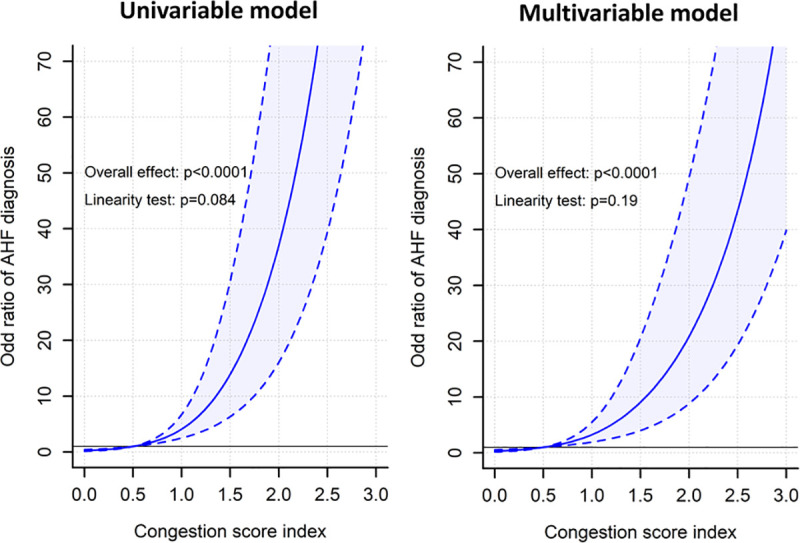
Association between CSI and discharge diagnosis of AHF.Multivariable model included the Brest score, which was calculated from age, comorbidity burden, dyspnea, ST segment abnormalities, and clinical congestion. Dotted lines/shaded regions represent 95% CI. AHF, acute heart failure; CSI, congestion score index.